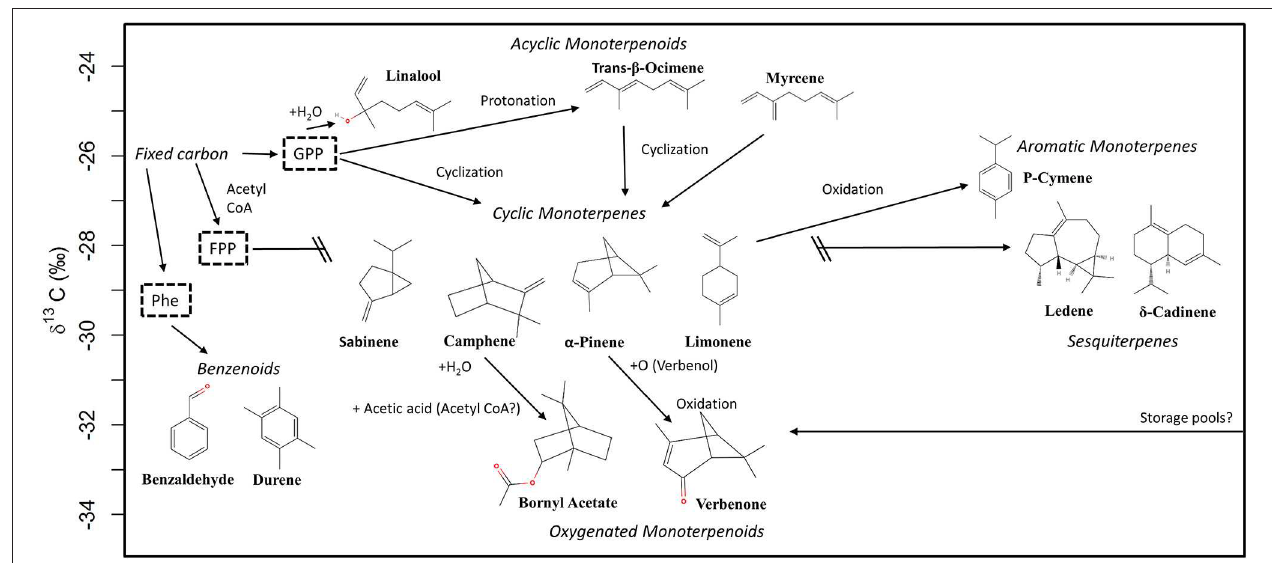
FIGURE 5 | Suggested scheme for different metabolic pathways for selected terpenoids and aromatics. The compound groups are given in italic letters. Processes, supposed to be involved in the formation of the respective volatile are given next to arrows. The information about these processes are taken from various studies mentioned in the discussion. We do not imply to have knowledge of the δ 13 C values of the respective precursors for monoterpenoids, sesquiterpenes, and benzenoids, hence they are displayed in dashed boxes. The formation of sesquiterpenes and cyclic monoterpenes must be seen independently of each other. The values for δ 13 C correspond to the July measurements. FPP, farnesyl pyrophosphate; GPP, geranyl pyrophosphate; Phe,